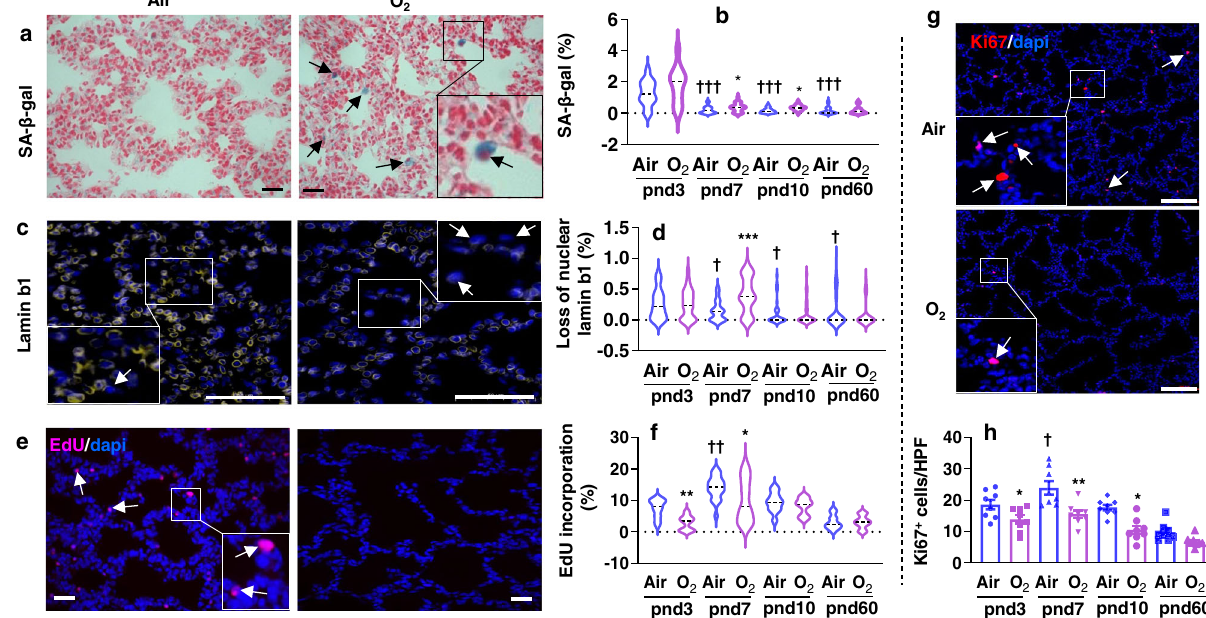
Fig. 1 | Lung senescence is observed in neonatal hyperoxia-exposed mice. C57BL/6J neonatal mice(<12hold)were exposed to airor hyperoxia(>95%O 2 )for 3days.Somemicewerethenallowedtorecoverinroomairuntilpnd60( a – d , g , h ). a SA- β -gal activity was detected by cytochemistry using X-gal as a substrate, and nucleiwere stained with nuclear fastred in mouse lungs. Representative images of SA- β -gal staining in mouse lungs at pnd7. Arrows denote SA- β -gal positive cells (blue). b Cellspositive forSA- β -gal werecountedand normalized to totalnumbers of nuclei in the lung. c Immuno fl uorescence was performed to determine expres- sionoflaminb1.Representativeimagesoflaminb1staininginmouselungsatpnd7. Arrows denote cellslacking nuclearlamin b1. d Cells lacking nuclear lamin b1 were counted and normalized to total numbers of nuclei in the lung. e , f Mice were intraperitoneally injected with EdU before sacri fi ce, and lung tissues were stained